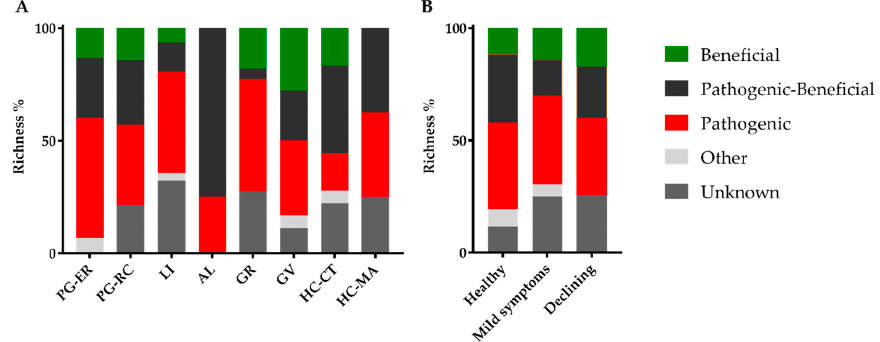
Figure 2. Cork oak endophytic fungal functional groups presented in cork oak forests ( A ) and disease severity level ( B ). Operational taxonomic units (OTUs) belonging to more than one functional group were added to both, except for the pathogenic–beneficial group that is represented as such.